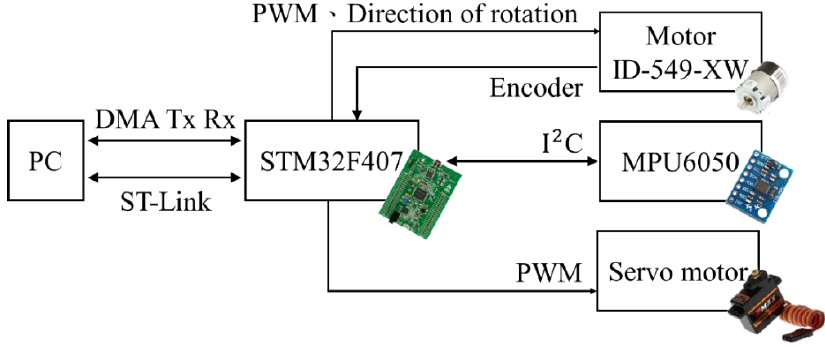
Figure 9. The signal processing units of the cube robot.